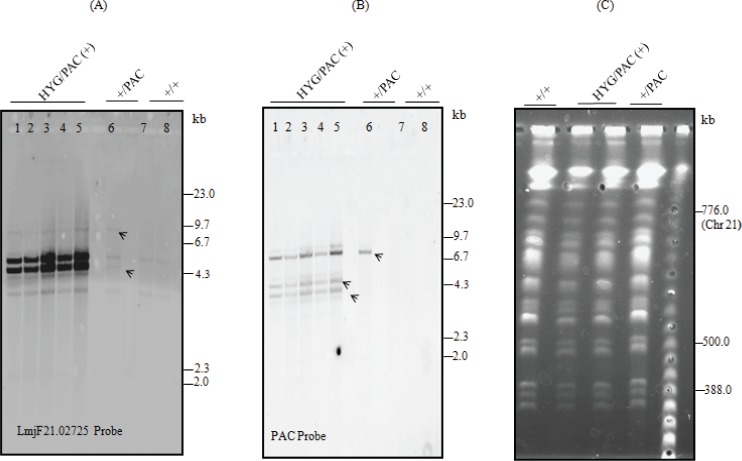
Analysis of the LmjF.21.0725 locus structure on independent transfectant clones and comparative analysis of their molecular karyotypes.(A) Southern blot of genomic DNA from five different PAC/HYG/ (+) Leishmania clones digested with SalI and hybridized with an LmjF21.0725 fragment as probe. Arrows pointing to unexpected bands present in all PAC/HYG/ (+) clones (lane 1 to 5) and in +/PAC (lane 6) cell lines, +/+ (lanes 7 and 8) that revealed the expected locus architecture (lane 7- L. major CC1; lane 8—L. major Friedlin). (B) Southern blot of genomic DNA digested with SalI and hybridized with PAC-specific probe; arrows indicate unexpected 8 kb bands in all mutants. (C) Molecular karyotype of L. major strains by pulsed field gel electrophoresis. +/+ = WT; +/PAC = heterozygous line with a PAC cassette replacing one endogenous allele; PAC/HYG/(+) = double replacement transfectant bearing both selectable markers and plasmid expressing LmjF21.0725 (pxNeoGFP-LmjF21.0725, addback transfectant). Marker: Lambda ladder (New England Biolabs).